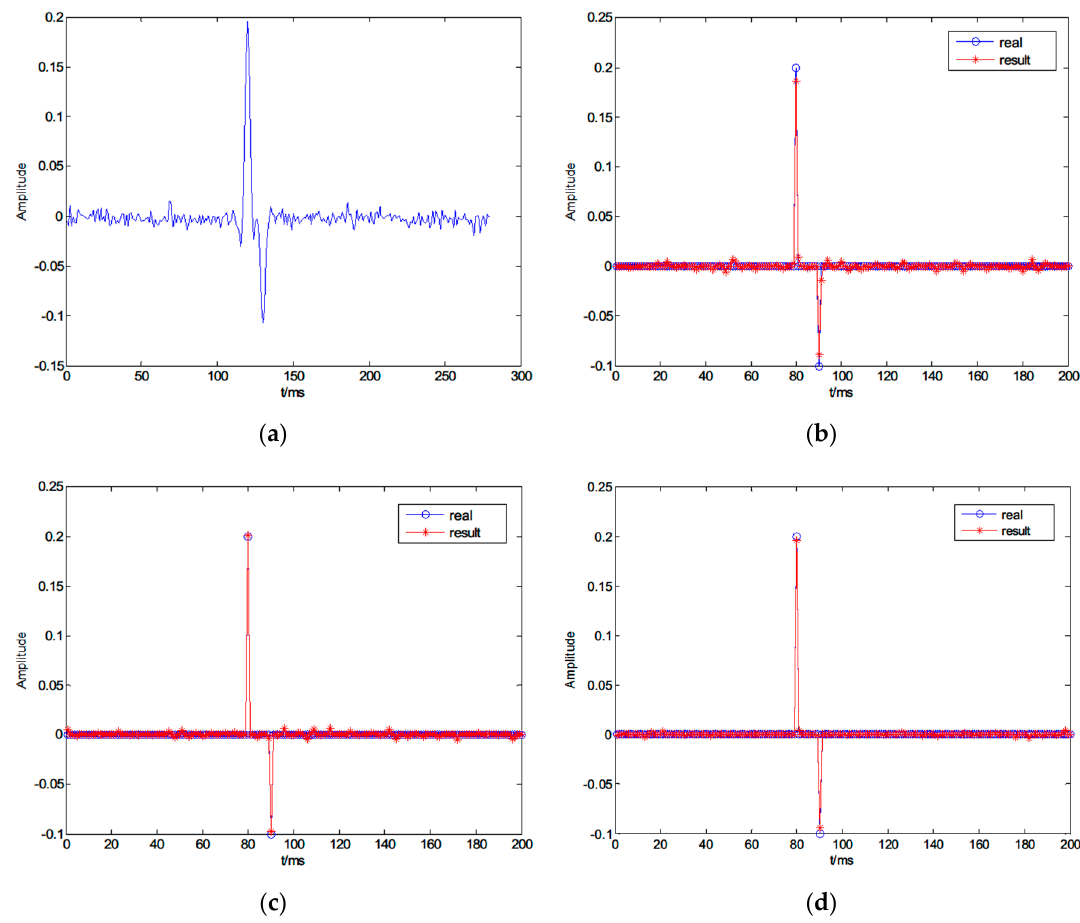
Figure 7. Inversion result of noisy synthetic seismic data. ( a ) Noisy seismic trace; ( b ) inversion result when λ = 0.01; ( c ) inversion result when λ = 0.04; and ( d ) inversion result when λ = 0.08.